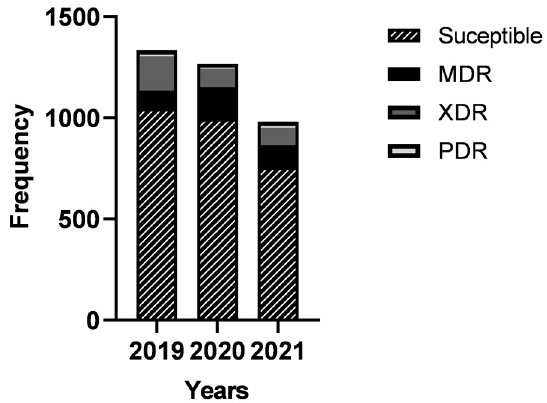
Figure 1. Distribution of multi-resistant P. aeruginosa isolates for the period 2019–2021. Most MDR and XDR P. aeruginosa isolates (61.8 and 61.1%, respectively) were isolated from male patients, while female patients were infected with more PDR isolates (Table 1). < 1 year of age, whereas the highest number of XDR isolates (36.8%, 25/68)